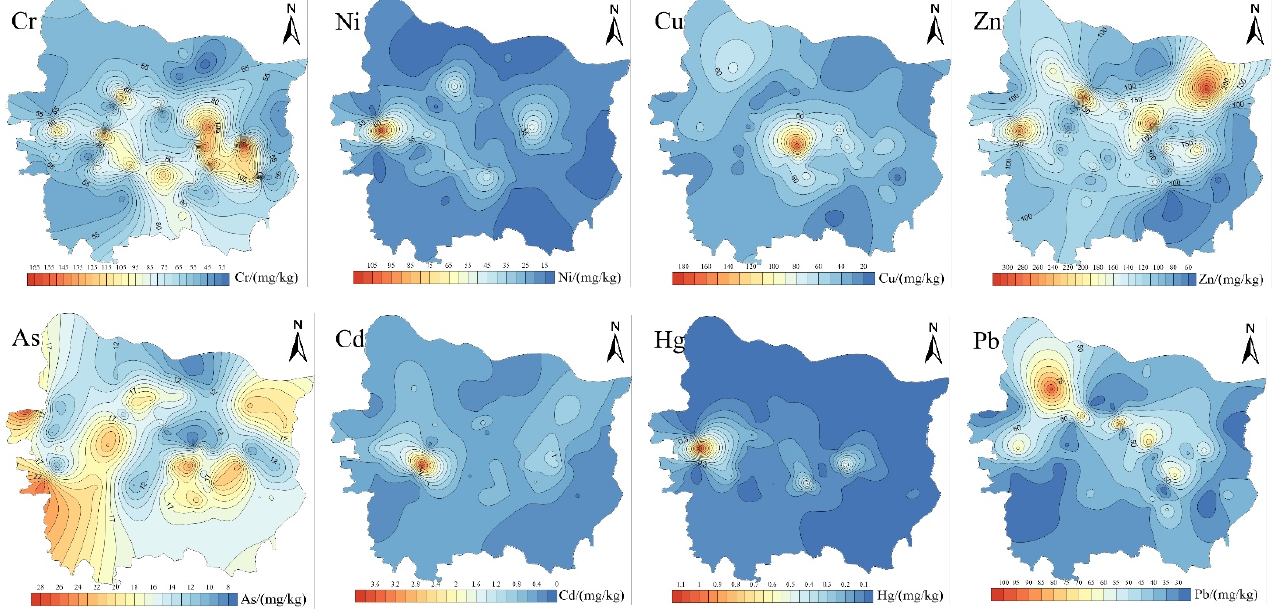
Figure 3. Spatial distribution of PTE concentration in road dust of Zhengzhou.